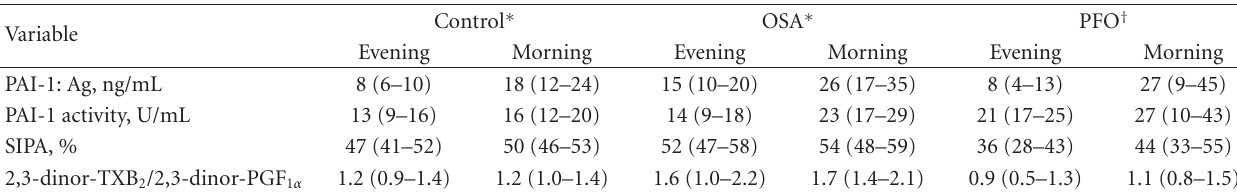
Table 2: Changes in fibrinolytic and platelet parameters from evening to